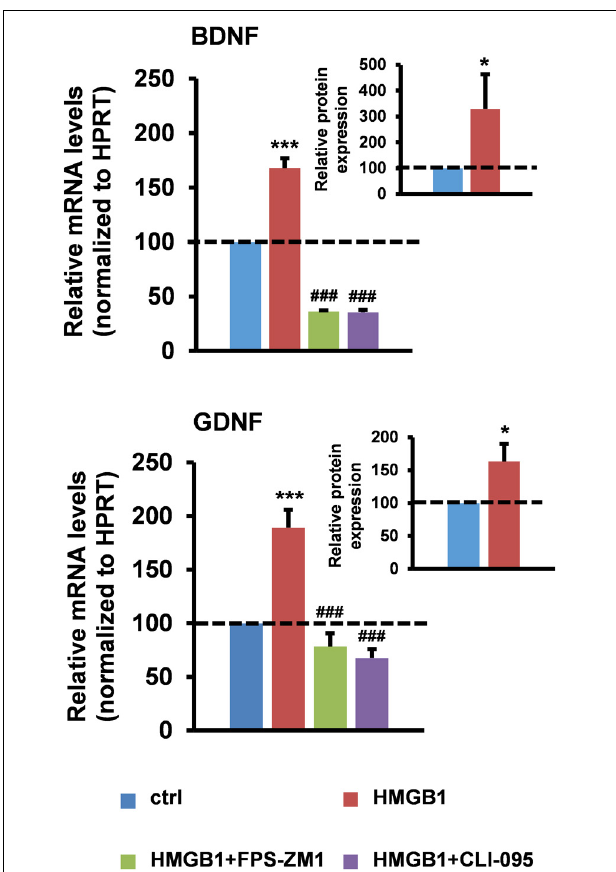
FIGURE 1 | High-mobility group box 1 (HMGB1) stimulates trophic factor expression in mouse spinal cord astrocytes. Astrocytes from the spinal cord of wild-type mice were pre-incubated for 1 h in the absence or in the presence of the RAGE antagonist FPS-ZM1 (50 nM) or the TLR4 antagonist CLI-095 (5 µ M), and then treated with recombinant disulfide-HMGB1 (3 µ g/ml) for 6 h. Total RNA was extracted and analyzed by RT-qPCR. Values (mean ± SEM) were normalized relative to hypoxanthine guanine phosphoribosyl transferase (HPRT) and expressed as percentage of untreated cells (ctrl) (main charts). ∗∗∗ p < 0.0001 HMGB1 vs. crtl; ### p < 0.0001 HMGB1+FPS-ZM1 or +CLI-095 vs. HMGB1, one-way ANOVA followed by Bonferroni post hoc test, n = 3–17 experiments, in triplicate. Intracellular BDNF and GDNF protein levels from wild-type spinal cord astrocytes were quantified by ELISAs after treatment with recombinant disulfide-HMGB1 (3 µ g/ml) for 6 h. Values (mean ± SEM) were expressed as percentage of untreated cells (ctrl) (inset charts). ∗ p < 0.05 HMGB1 vs. ctrl, two-tailed unpaired t -test, n = 6 experiments, in